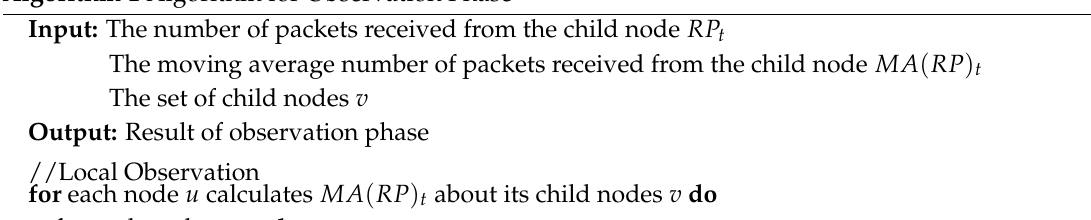
Algorithm 1 Algorithm for Observation